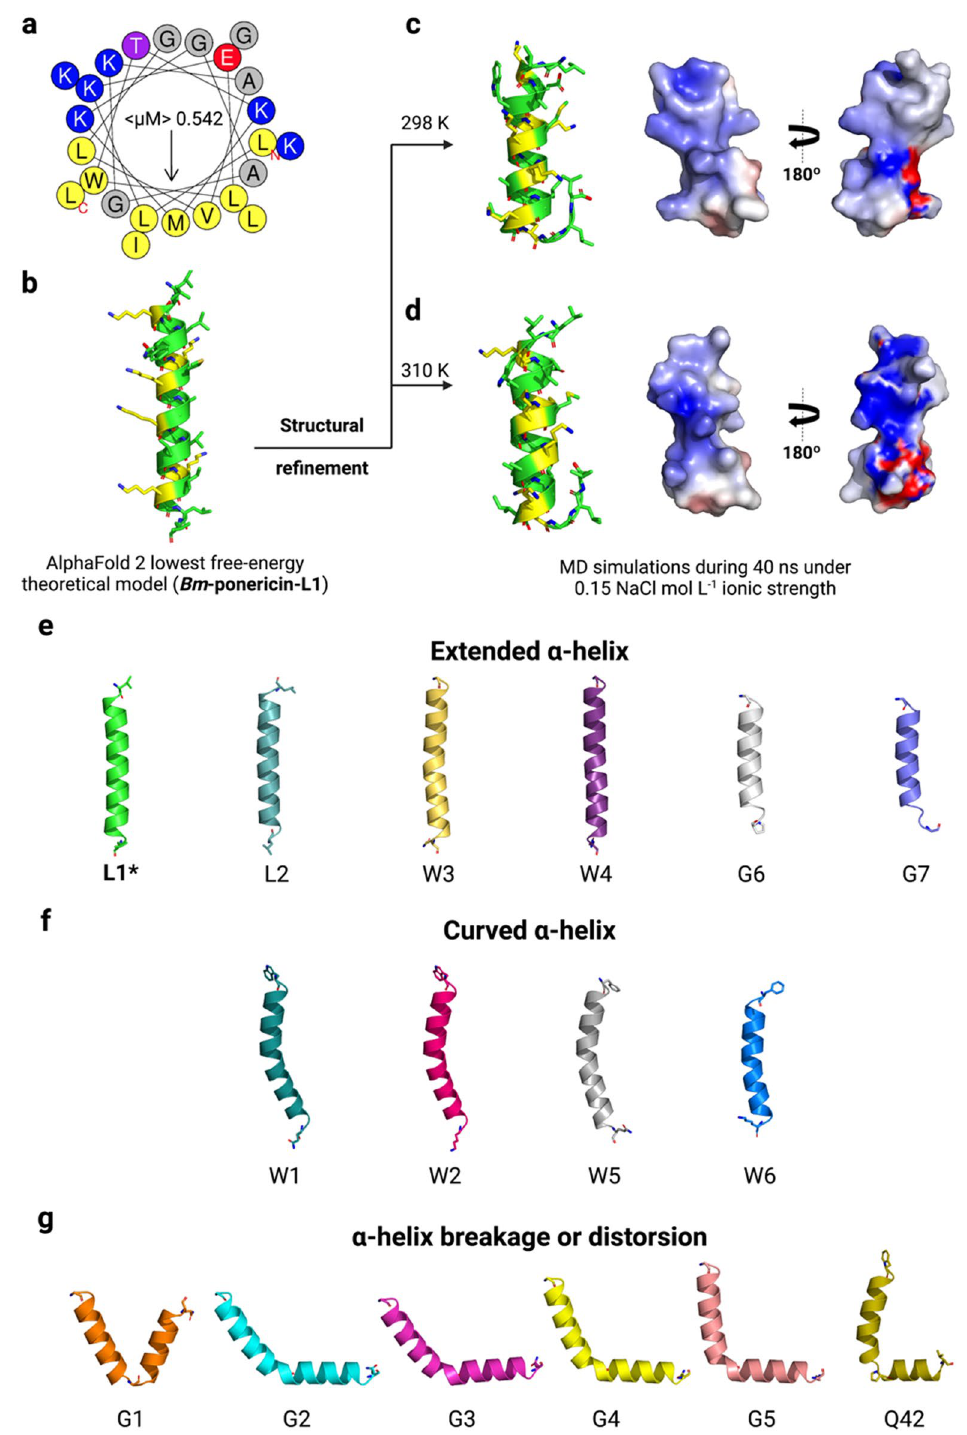
Figure 7. In silico structural characterization of Bm -ponericin-L1. ( a ) The helical wheel diagram for Bm - ponericin-L1is shown, along with its lowest free-energy three-dimensional theoretical model. ( b ) The structural refinement was performed at 298 ( c ) and 310 K ( d ), and 0.15 NaCl mol L −1 ionic strength through MD simulations (40 ns). A total of 16 ponericin-like peptides were retrieved from APD and submitted to molecular modeling. These peptides were divided into three main classes of structure profiles, including ( e ) extended α-helix, ( f ) curved α-helix and ( g ) α-helix breakage or